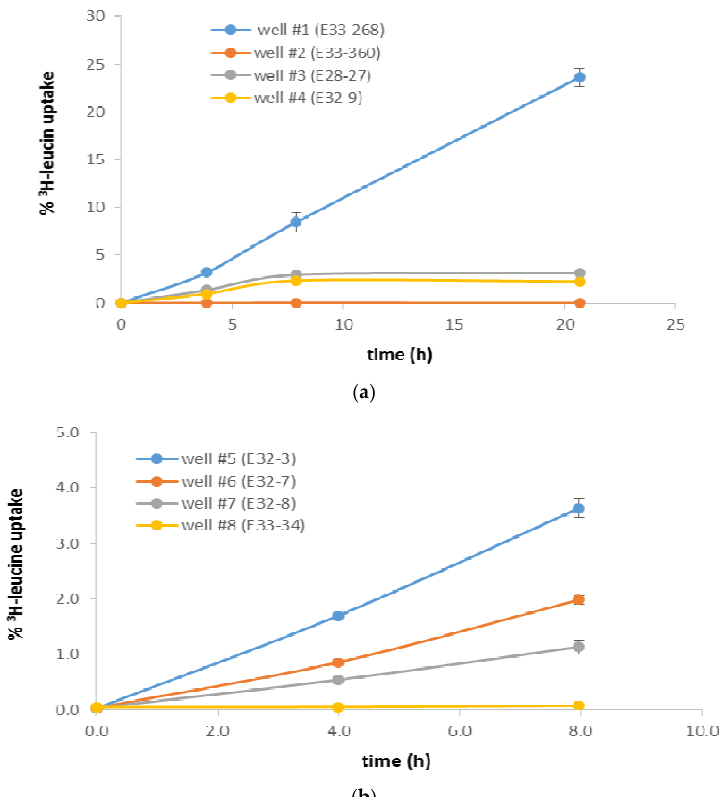
Figure 3. ( a ) Tritiated leucine uptake (as percentage of label added) in wells #1–#4, from 0 to 21 h. Results are based on duplicates, with standard deviation bars as shown. ( b ) Tritiated leucine uptake (as percentage of label added) in wells #5–#8, from 0 to 8 h. Results are based on duplicates, with standard deviation bars as shown.